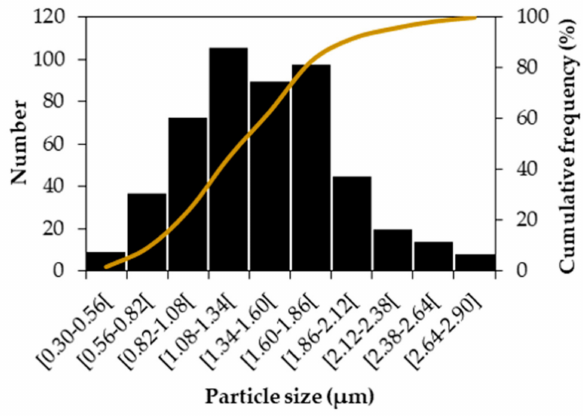
Figure 17. Size distribution of the TiC particles in the composite zone (two perpendicular diameters were measured in 500